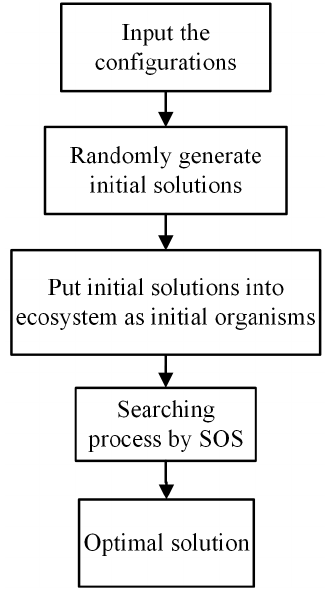
Figure 1. Flowchart of pipe network analysis model (PNSOS).